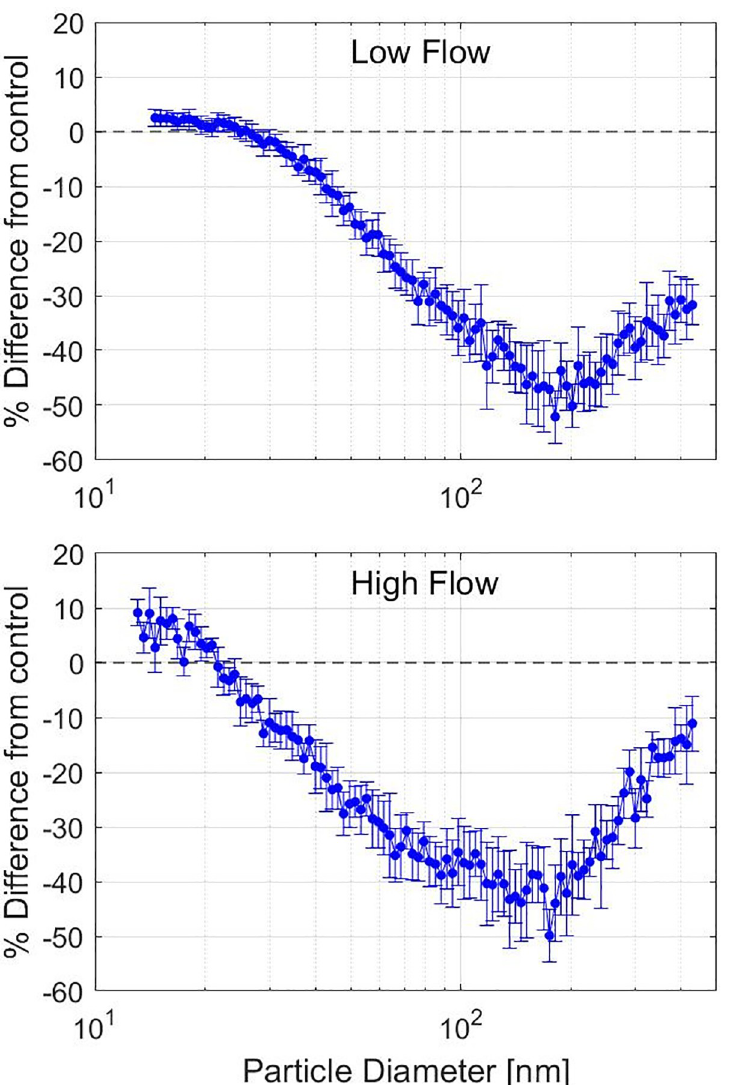
Fig 6. Efficiency reduction of irradiated Model 2 respirator. Efficiency reduction of 25 kGy(tissue) Model 2 respirator when compared to control respirator on the LSFS. Note that the small particle sizes in the range of 10–20 nm are heavily influenced by many factors (such as temperature) and the slight increase in efficiency needs further